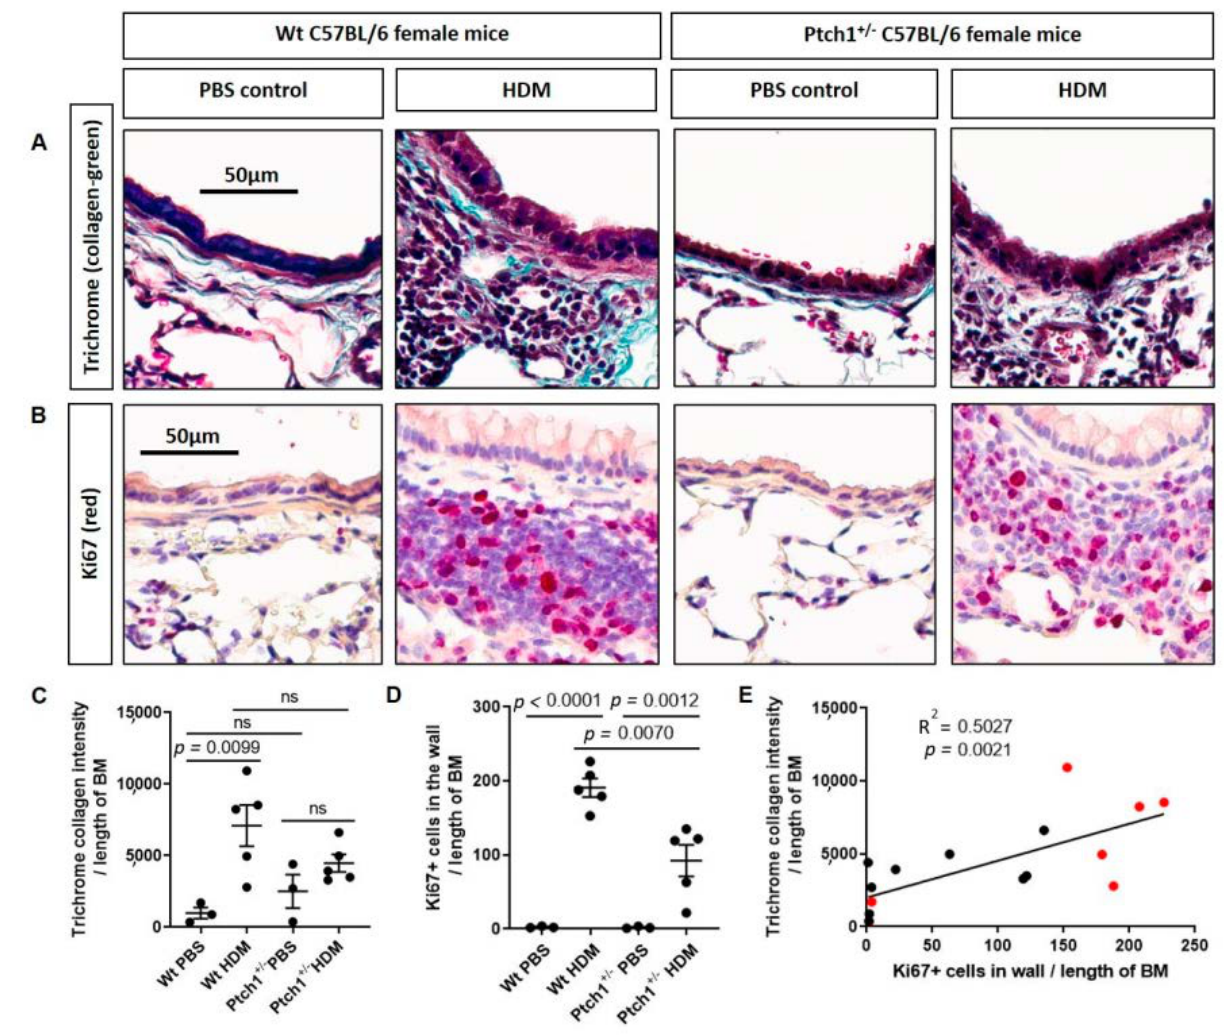
Figure 6. Ptch1 +/ − mice were partially protected from HDM-induced increase in total collagen expression and Ki67+ cells in the sub-epithelial walls compared to WT mice. Paraffin − embedded mouse lung tissues from C57BL/6 female WT PBS − treated ( n = 3), WT HDM − treated ( n = 5), Ptch1 +/ − WT PBS-treated ( n = 3) and Ptch1 +/ − HDM-treated ( n = 5) mice after PBS or HDM exposures were stained with ( A ) Trichrome and ( B ) Ki67 antibody. Sub − epithelial ( C ) collagen expression (light green) and ( D ) Ki67+ cells (red) were normalized to the length of the basement membrane. ( E ) The correlation between sub − epithelial collagen expression and Ki67+ cells is shown. One-way analysis of variance with Bonferroni’s multiple comparisons test was used in panels ( C , D ). Linear regression analyses were used in panel ( E ). Red dot = WT PBS and HDM − treated mice, black dot = Ptch1 +/ − PBS and HDM − treated